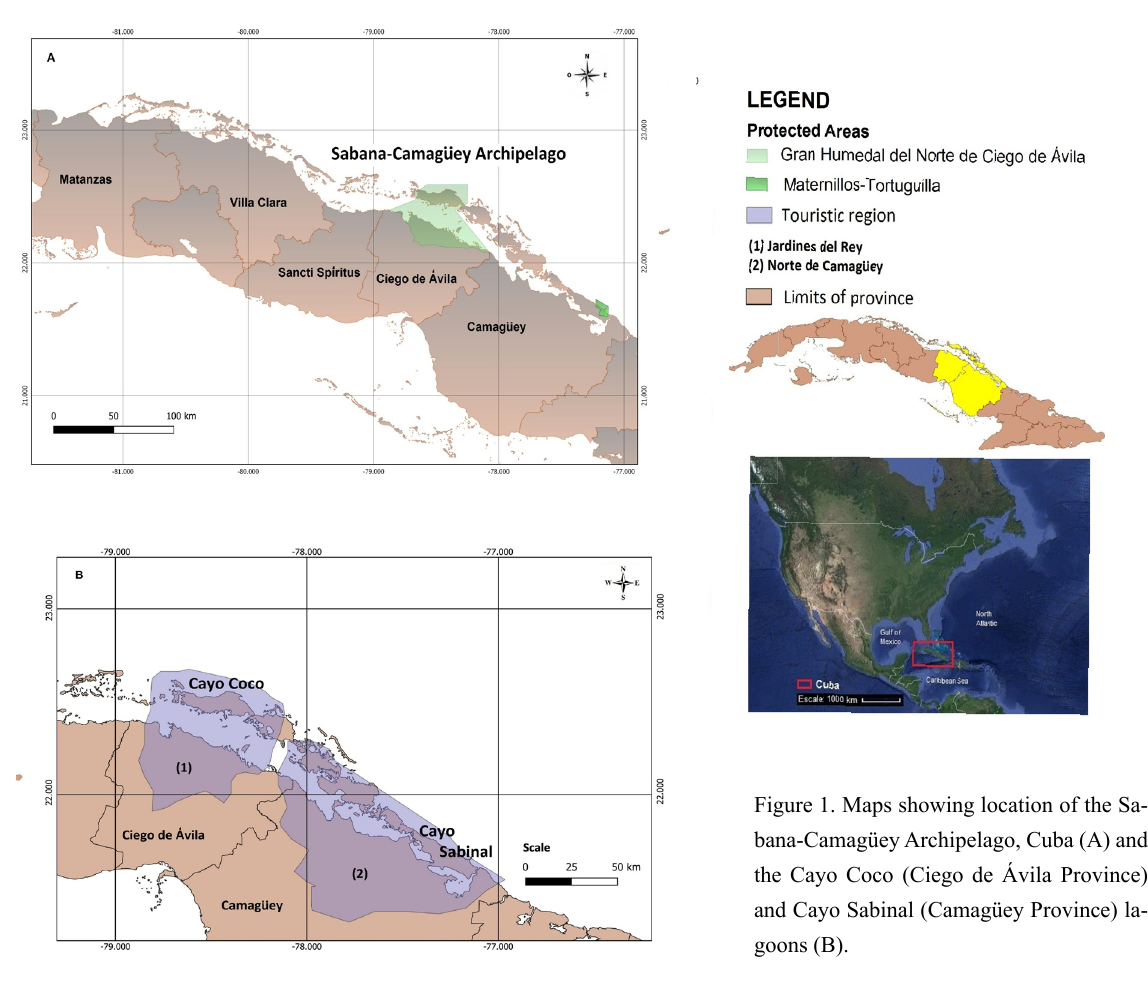
Figure 1. Maps showing location of the Sa- bana-Camagüey Archipelago, Cuba (A) and the Cayo Coco (Ciego de Ávila Province) and Cayo Sabinal (Camagüey Province) la- goons